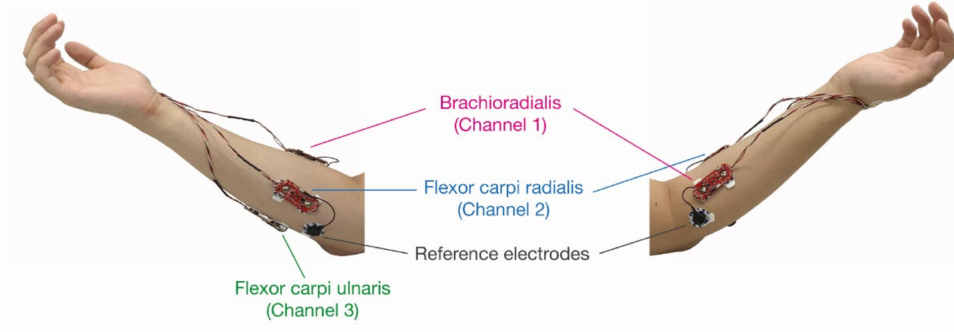
Figure 2. Placement of EMG sensors and electrodes on a forearm.